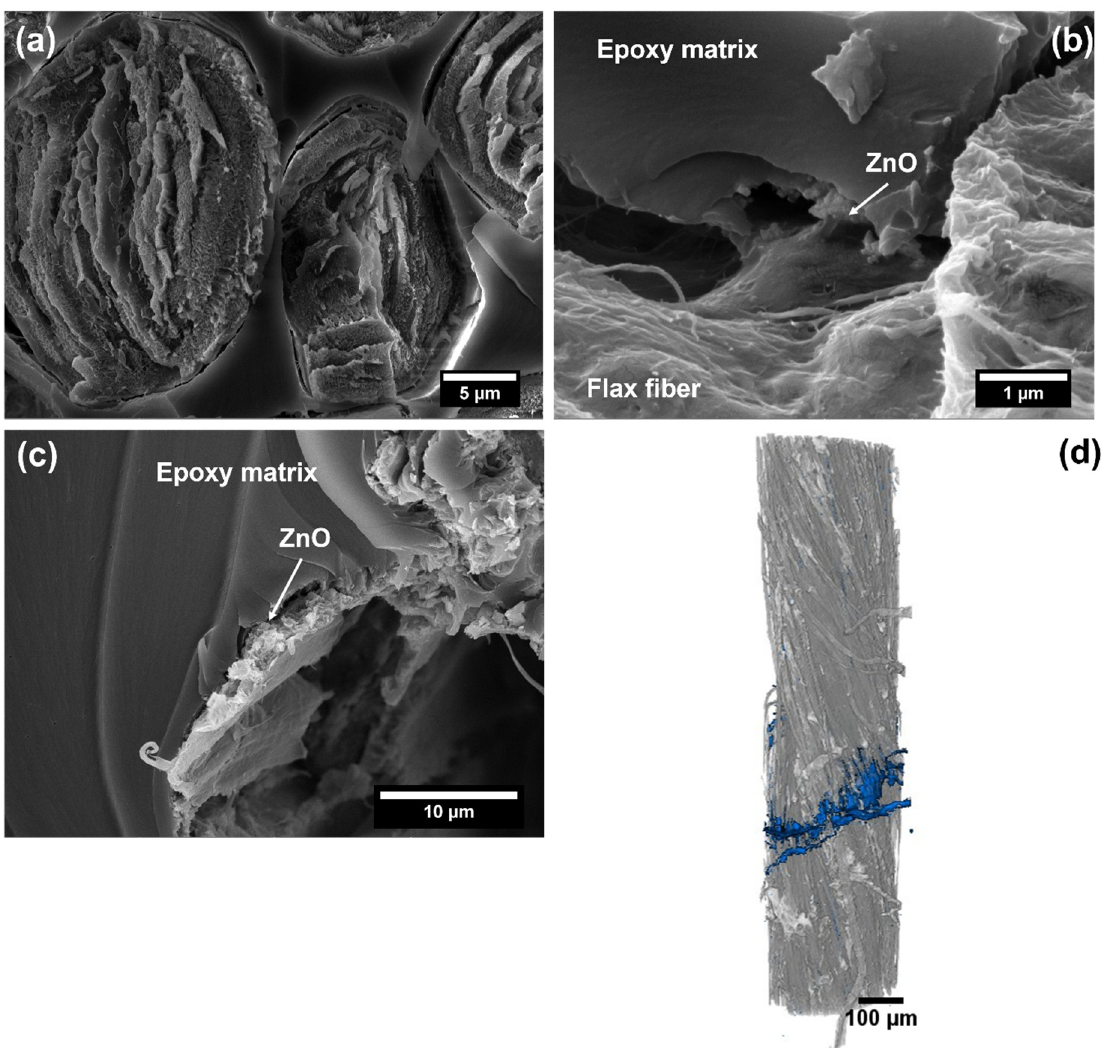
Figure 10. ( a – c ) FESEM images, at different magnifications, detailing the fracture morphology of a single ZnO-coated flax yarn composite after the single yarn fragmentation test and ( d ) volumetric reconstruction from micro-CT scans of ZnO-coated flax yarn (dark grey) and the fracture zone (blue).